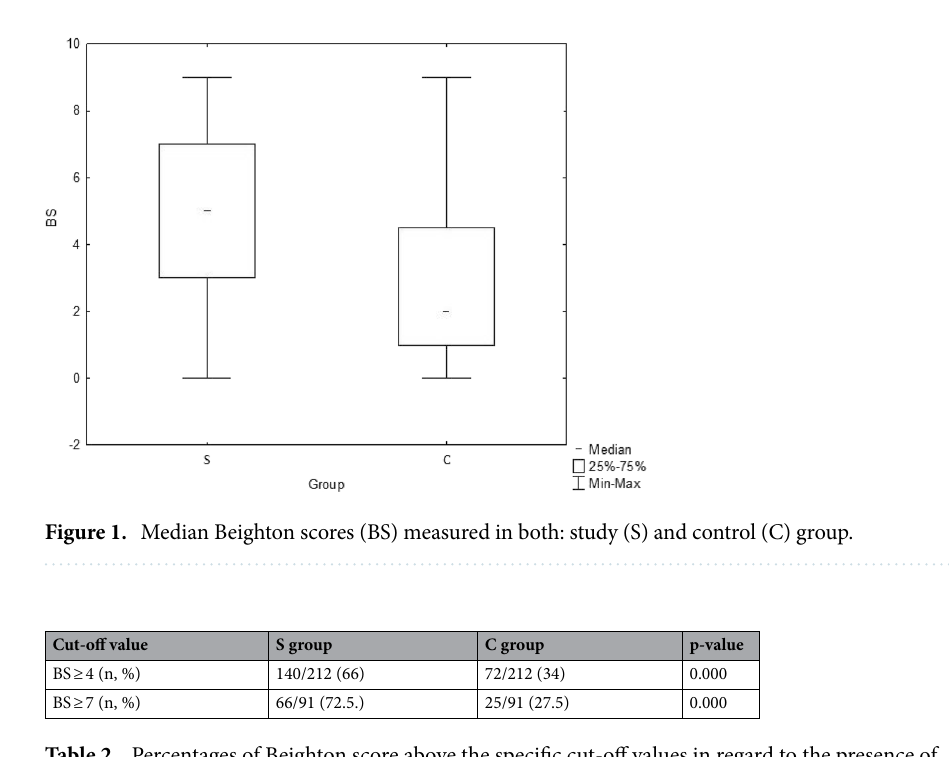
Table 2. Percentages of Beighton score above the specific cut-off values in regard to the presence of constipation. S study group, C control group, BS Beighton score.